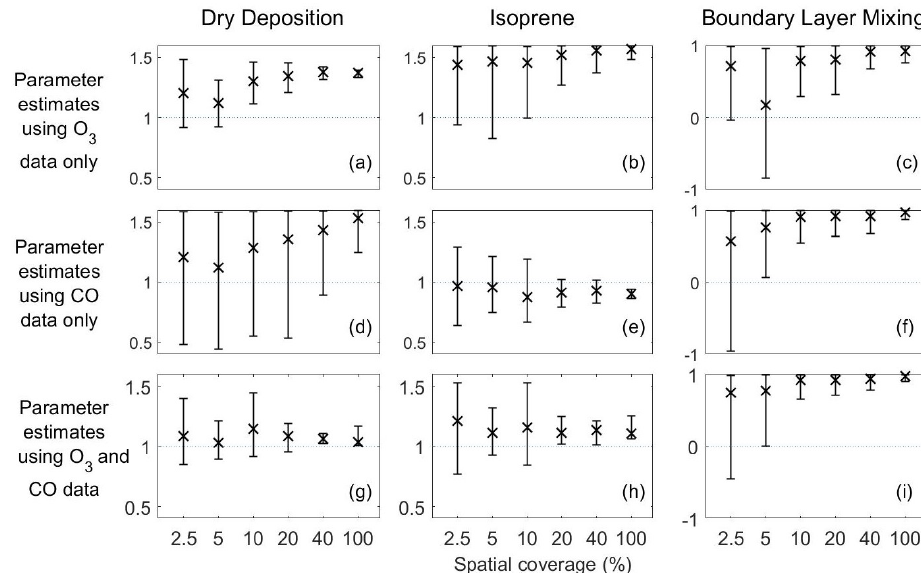
Figure 10. Means and 95% credible intervals of 3000 samples of the dry deposition, isoprene and boundary layer mixing scaling parameters from posterior distributions using the MCMC algorithm based on reanalysis datasets from scenarios 73–90 (Table 1). The first and second rows show these parameters estimated using one stream of data (O 3 for the first row and CO for the second row), while the third row shows estimates using two data streams (O 3 and CO).